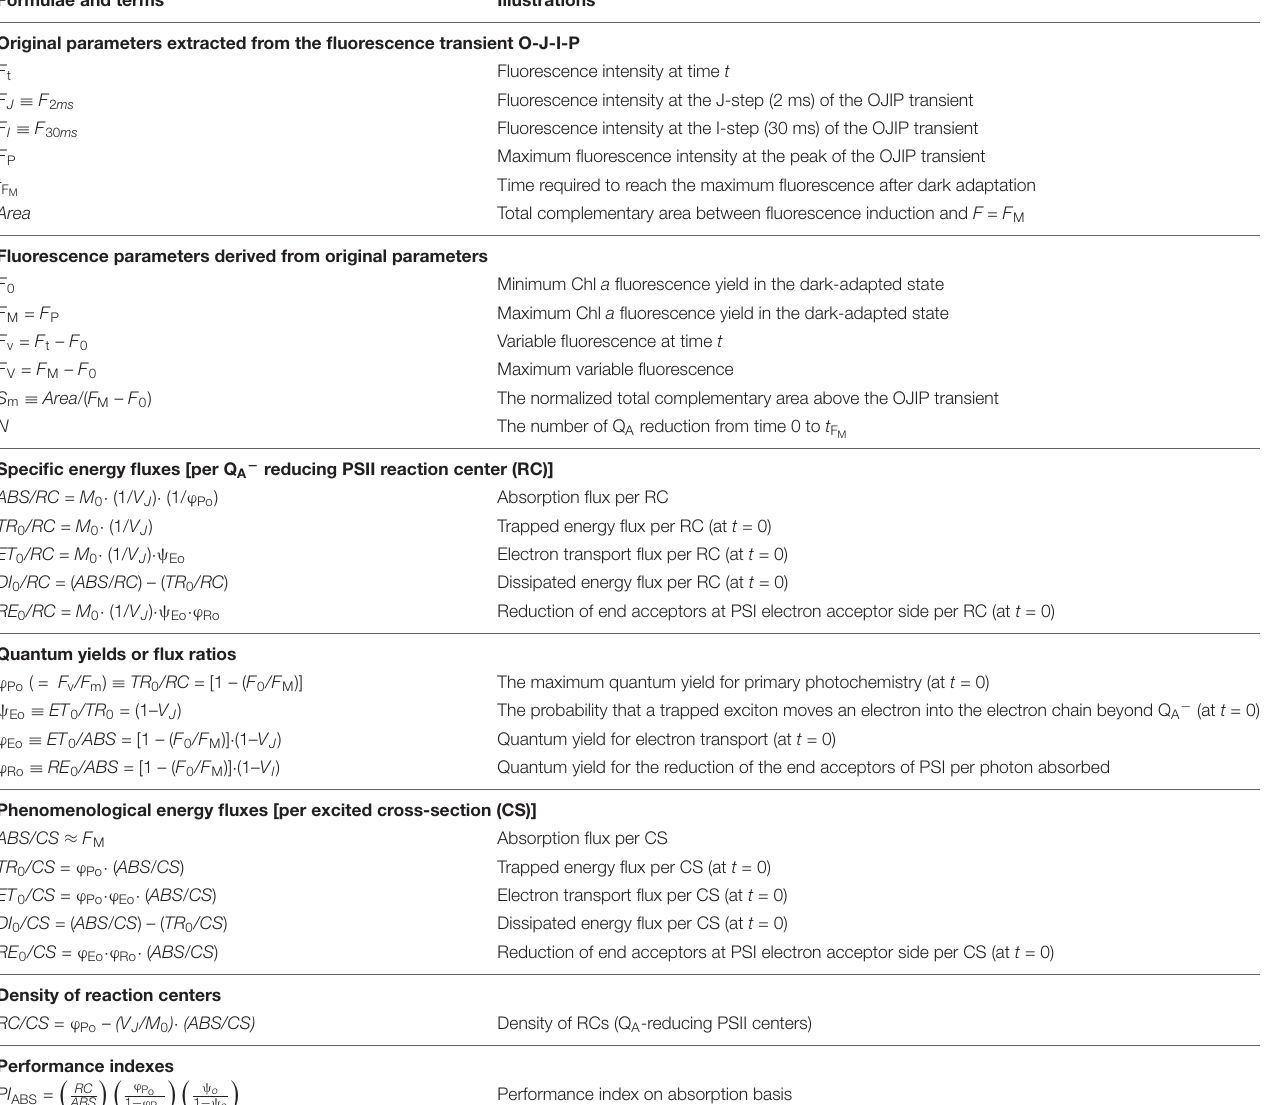
TABLE 1 | Formulae and glossary of terms used in the JIP-test